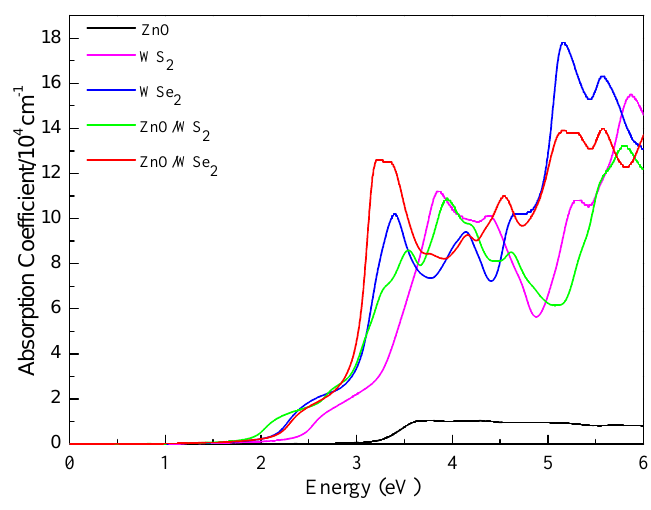
Figure 8. Calculated optical absorption curves of ZnO, WS 2 , and WSe 2 monolayers and of ZnO/WS 2 and ZnO/WSe 2